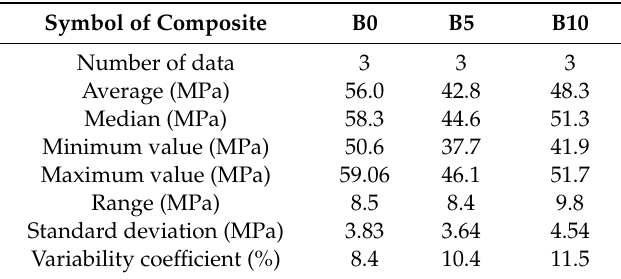
Table 9. Basic statistical parameters. Characteristics of concrete composite after 180 days.